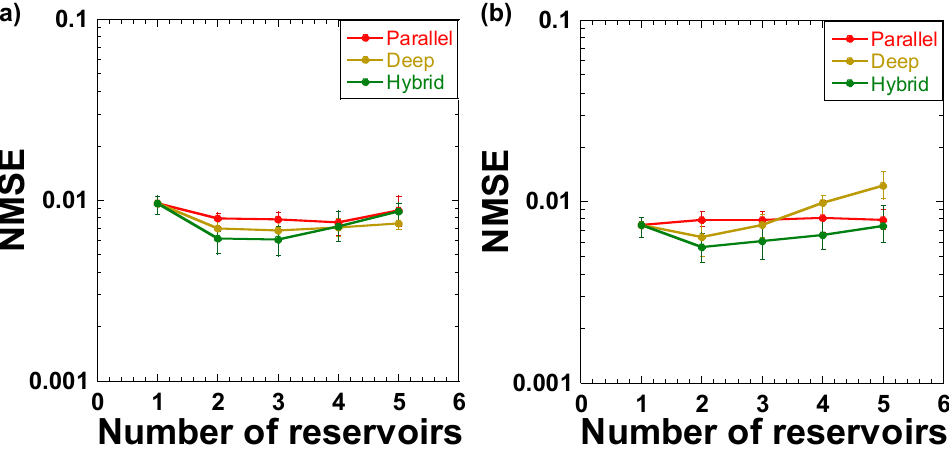
Figure 7: Normalized mean-square error (NMSE) of the chaotic time-series prediction task as the number of reservoirs k is changed for parallel (red), deep (brown), and hybrid (green) configurations. (a) The number of nodes for each reservoir is fixed at N = 280. (b) The total = number of nodes is fixed at N total